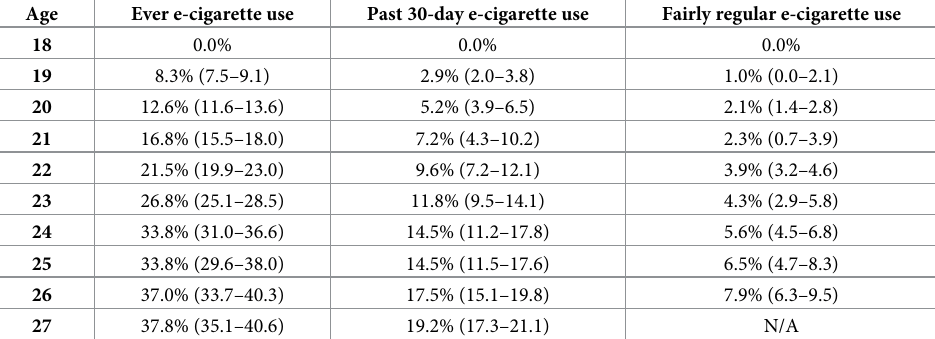
Table 2. Estimated hazard function � of the age of initiation of e-cigarette outcomes and 95%CIs a for the overall sample of PATH ¥ USA young adults (aged 18–24).